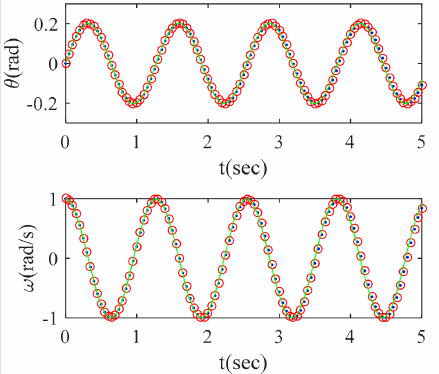
Figure 10. The results under reduced attitude and triangle function (1).